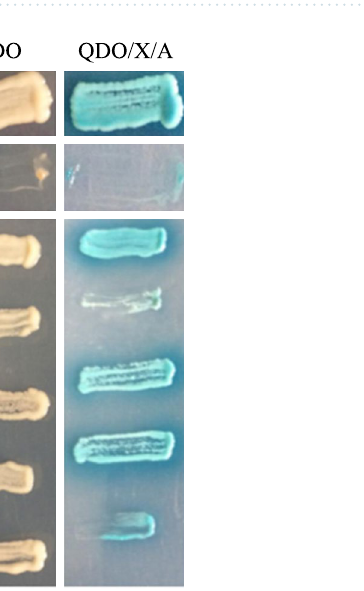
Table 2. Protein interactions, plasmids used, and the results obtained in this work. * - = negative interactions and + = positive interactions.